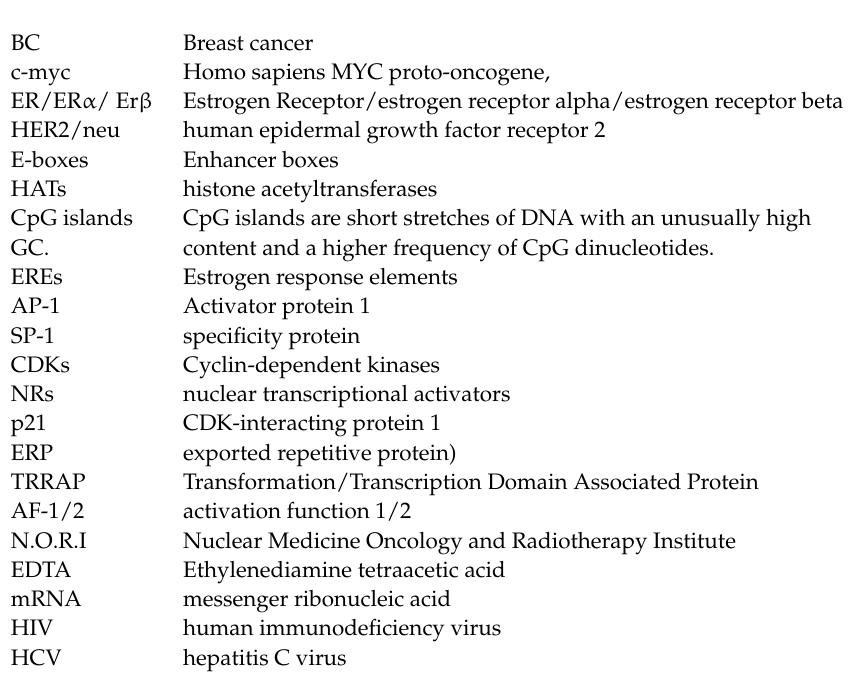
Table S2: Genetic Expression Parameters and